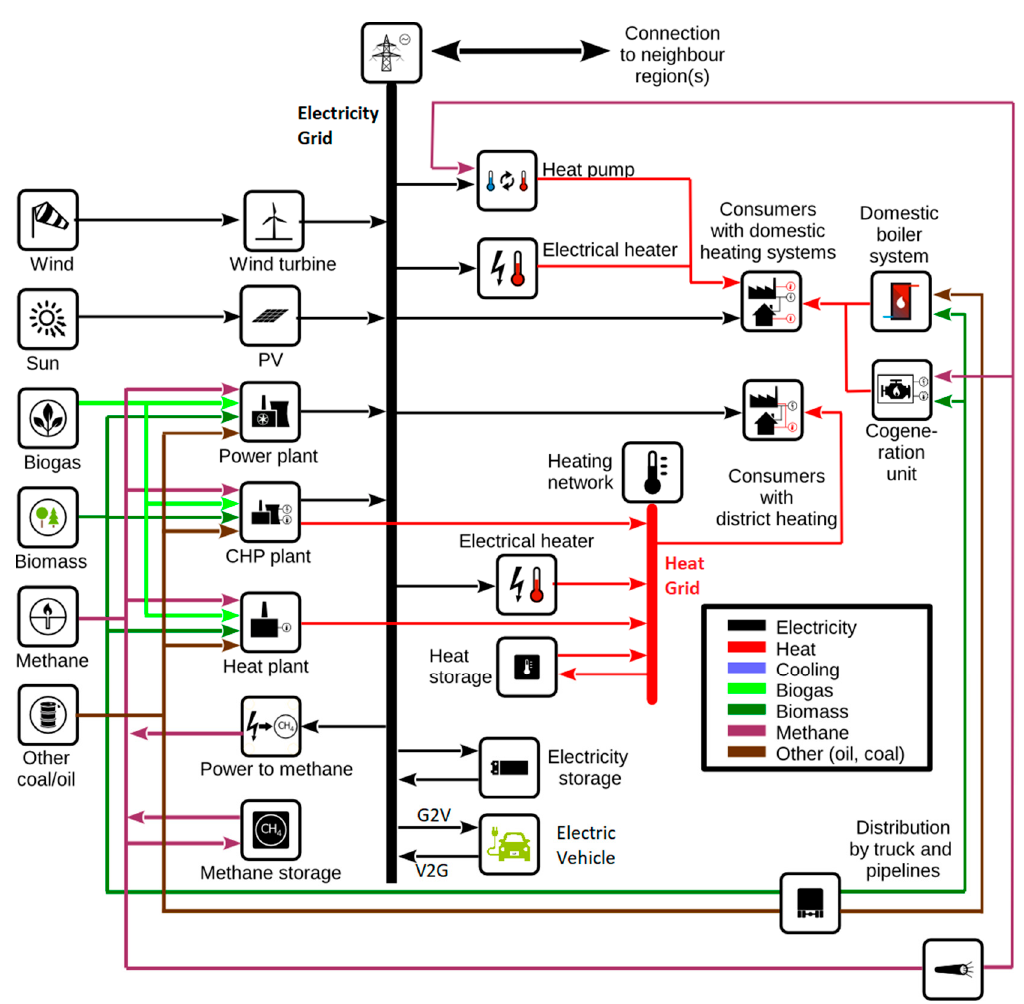
Figure 10. Exemplary sector ‐ coupled energy system using Oemof. Adapted from [127].